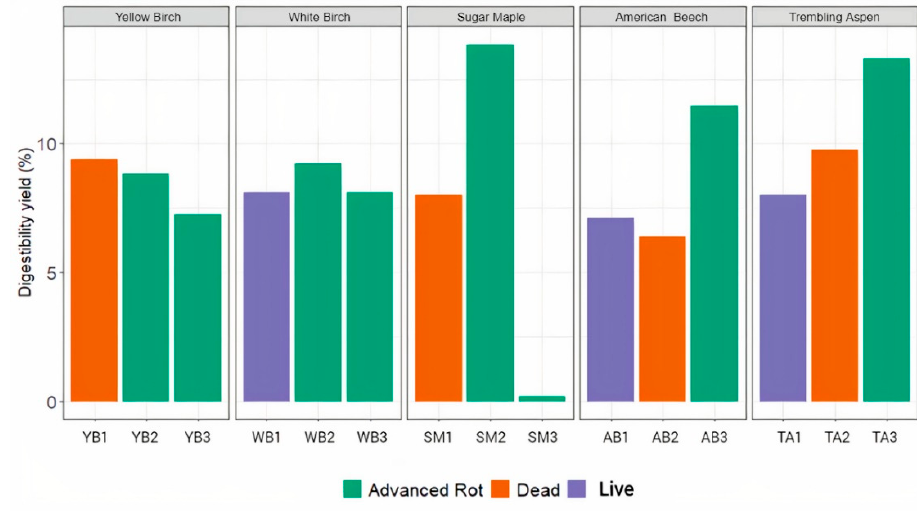
Figure 6. Digestibility yield attained by each analyzed sample.